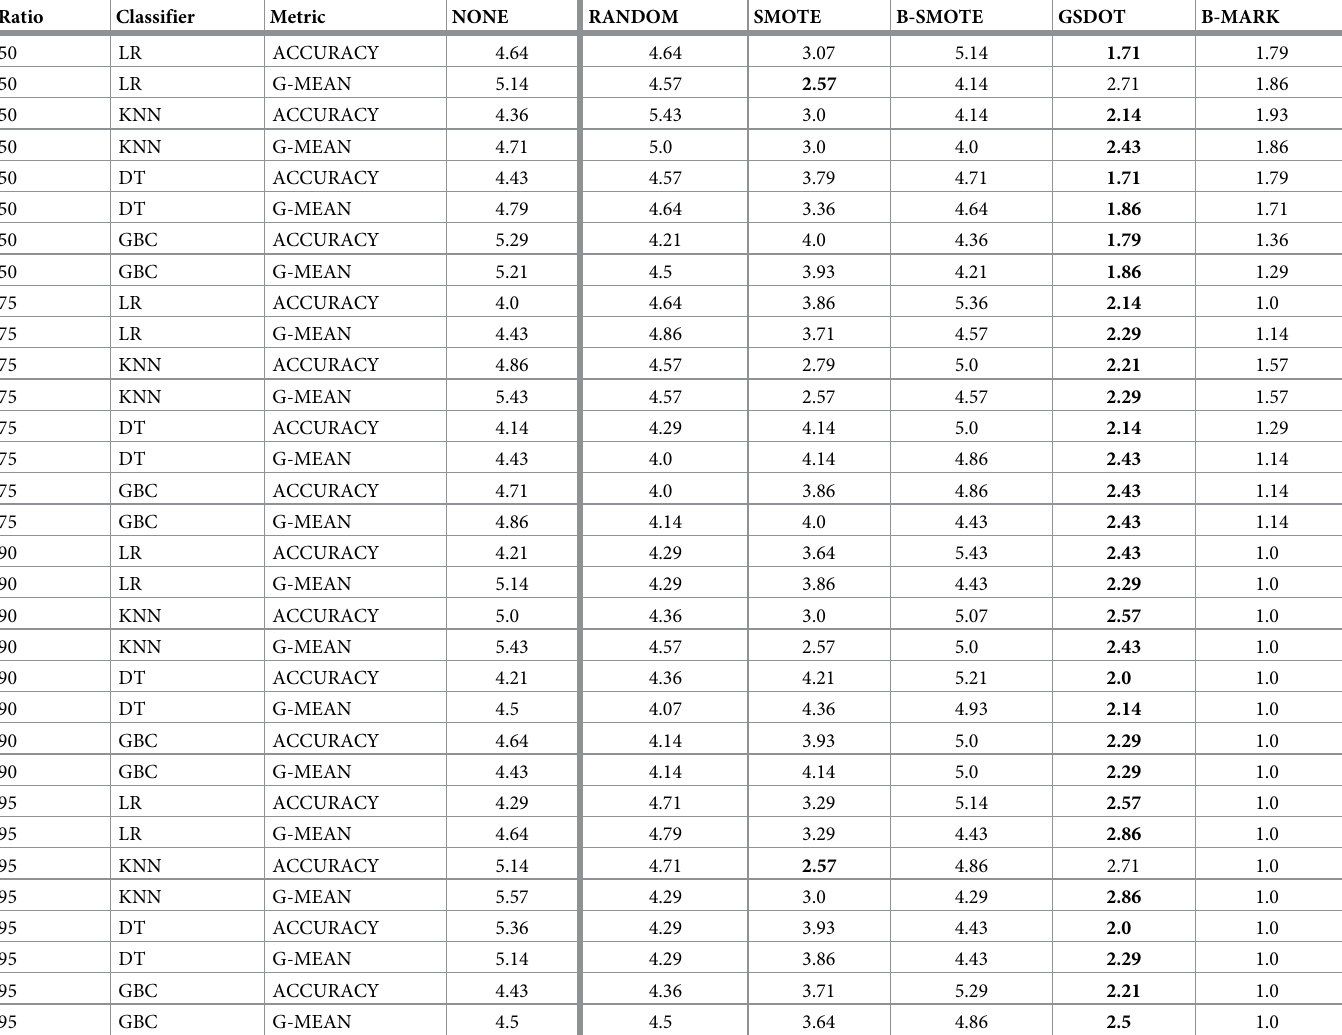
Table 4. Results for mean rankings of all methods.